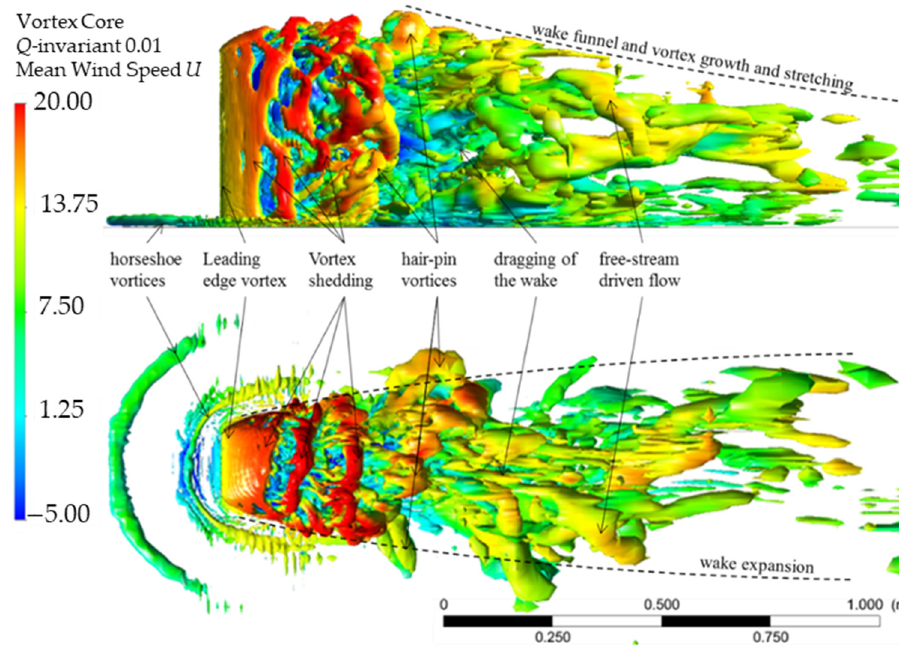
Figure 6. Vortex core visualization ( Q invariant 1 / s 2 ), with flow pattern identification.